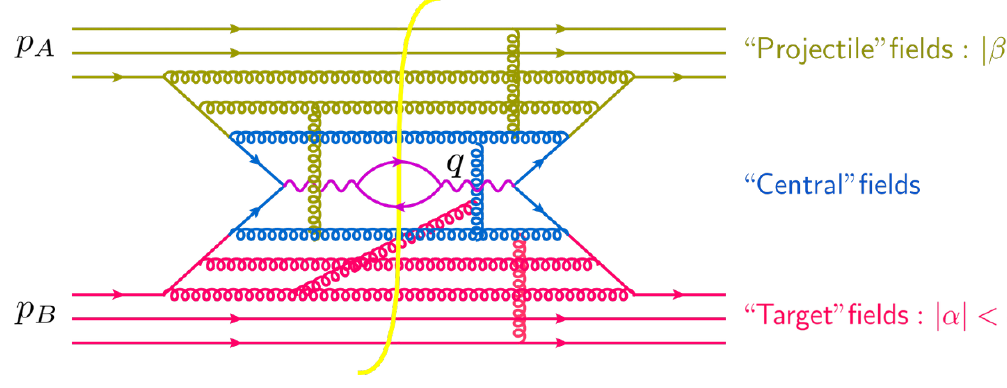
Figure 2 . Rapidity factorization for particle